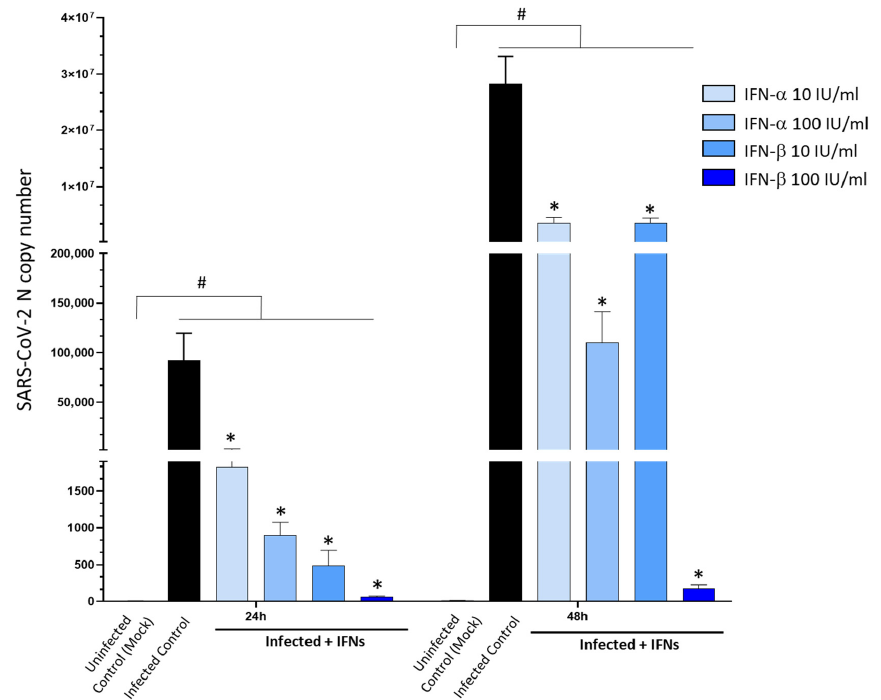
Figure 7. Dose- and time-related effects of Type-I Interferons in SARS-CoV-2 replication. Administration of Type-I Interferons (IFN- α , β , 10 and 100 IU/mL) dose-dependently inhibits SARS-CoV-2 replication in CaLu-3 cells. The strongest antiviral effect is observed for 100 IU/mL IFN- β , leading to nearly 100% inhibition of viral replication at 24 and 48 h. SARS-CoV-2 was not detected in the Uninfected Control (Mock). Results correspond to the absolute viral copy number of the SARS-CoV-2 N gene from cell supernatants that were quantified through a single-step, real-time, RT-qPCR by referring to a standard curve from RT-qPCR Ct values (IDT, Coralville, IA, USA). Results are presented as mean ± SEM from at least n = 3 independent experiments, each performed in triplicate. # p < 0.05 vs. Uninfected Control (Mock); * p < 0.05 vs. Infected Control.